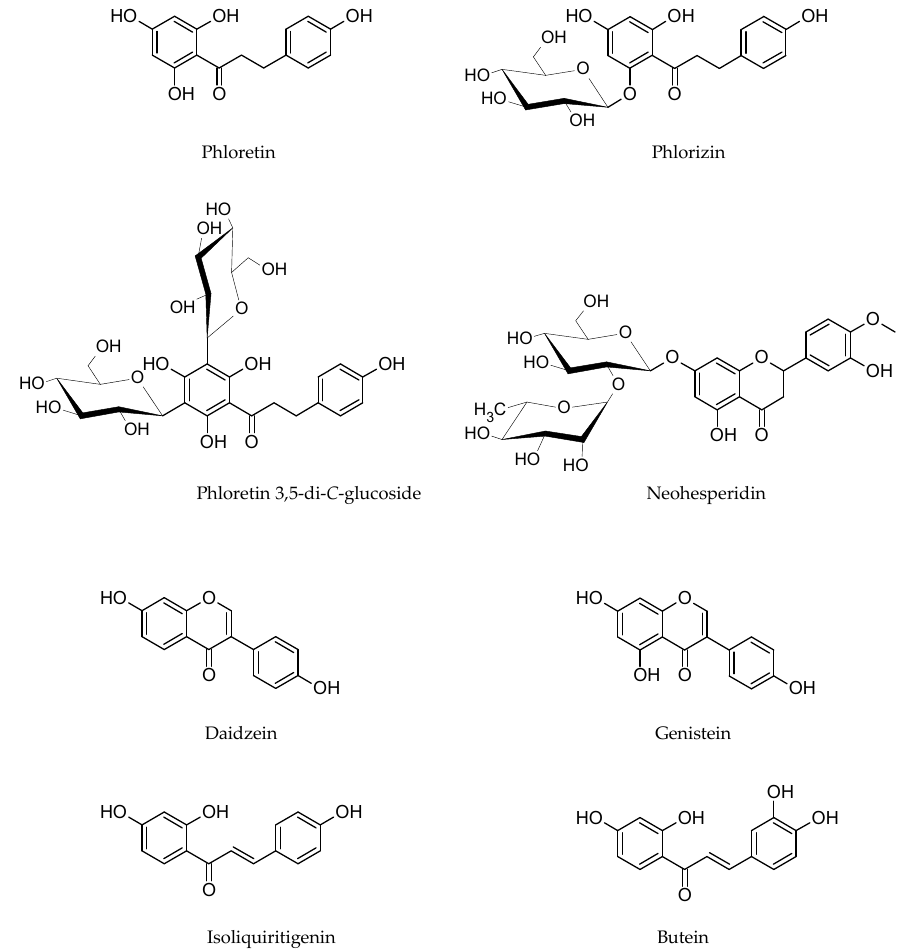
Figure 2. Structures of flavonoids occurring in different plants.